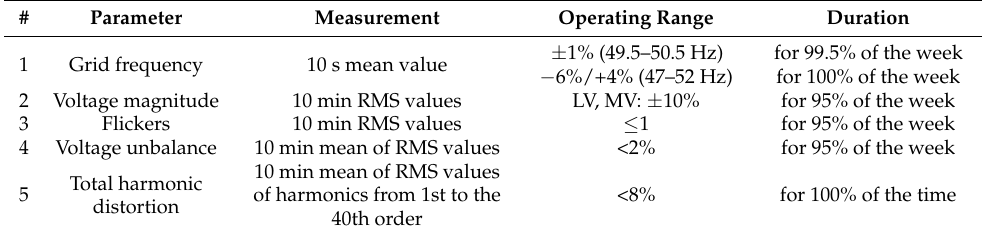
Table 2. Some power quality indices defined in EN 50160.